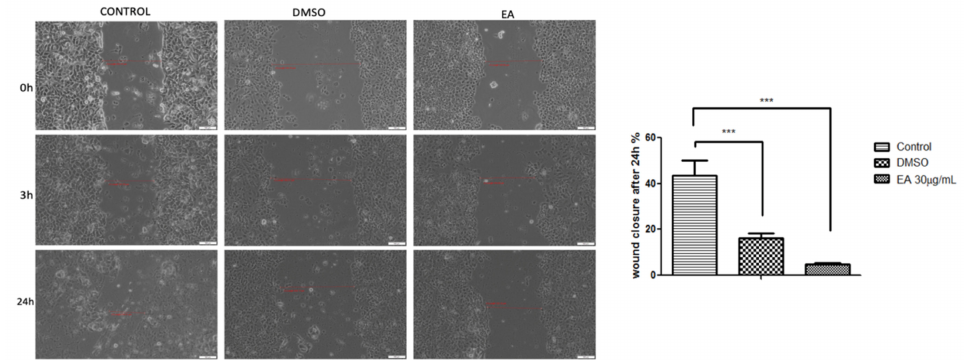
Figure 4. The migratory potential of MCF-7 human breast adenocarcinoma cells after treatment with EA extract at a concentration of 30 µ g/mL. The pictures were taken by light microscopy, and the scale bars represent 100 µ m. The bar graphs are expressed as percentage of wound healing after 24 h compared to the initial surface.